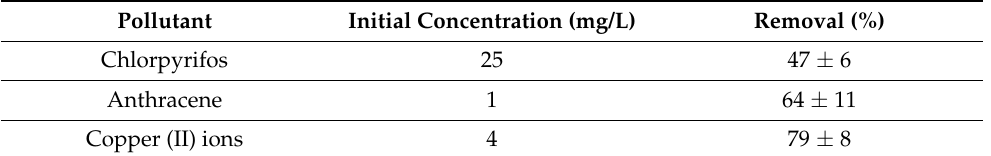
Table 1. Simultaneous removal of chlorpyrifos, anthracene, and copper (II) ions by alginate spheres with activated carbon in the presence of humic acid. The assays were carried out with aqueous solutions containing the three pollutants at the indicated concentrations and humic acid at 100 mg/L. An adsorbent dose of 6 mg/mL was applied, and the removal was measured at 24 h. The results are the mean ± SE from triplicate